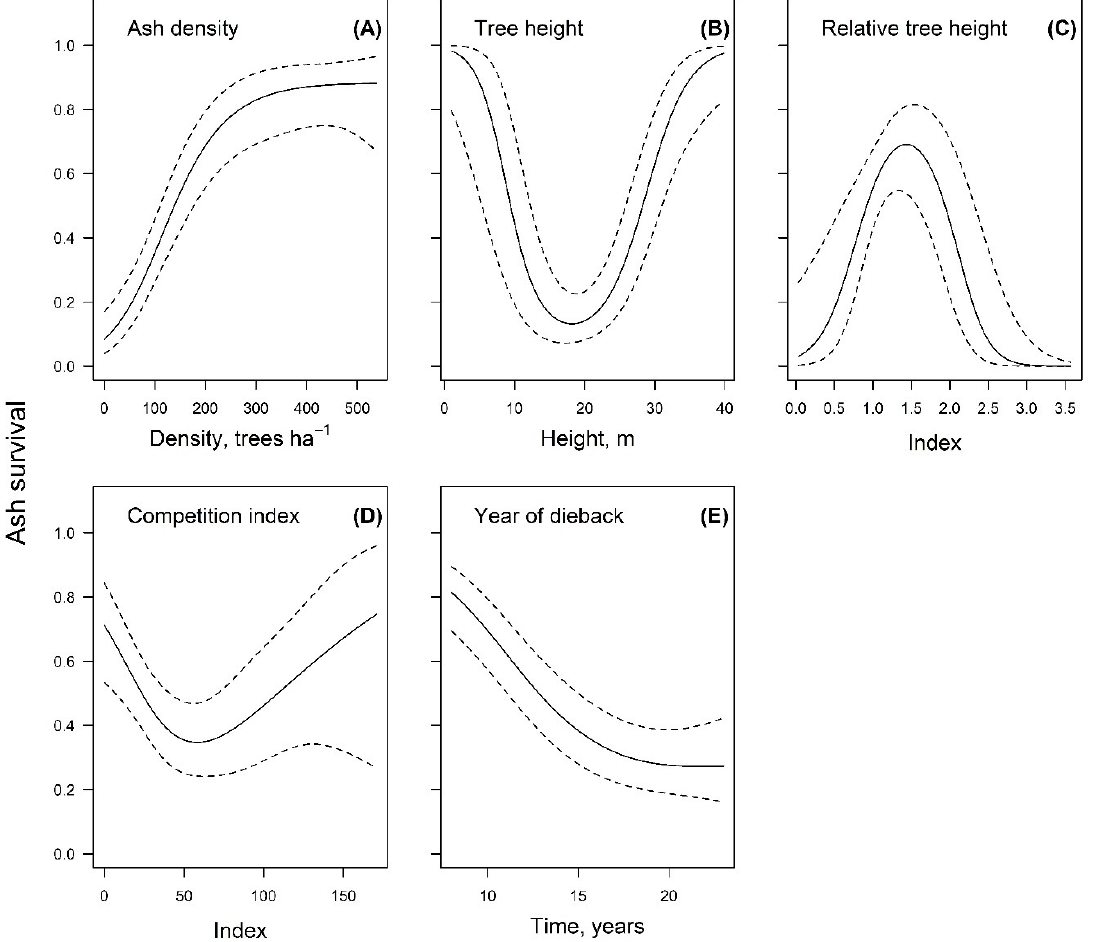
Figure 2. Nonlinear response of survival of common ash during 2005–2020 to tree- and stand level- level variables. The dashed lines indicate 95% confidence interval of the response curves (( A )—density of ash, ( B )—height of ash, ( C )—ash height relative to the mean of the stand, ( D )—competition index representing local density, and ( E ) time since the supposed onset of the dieback).